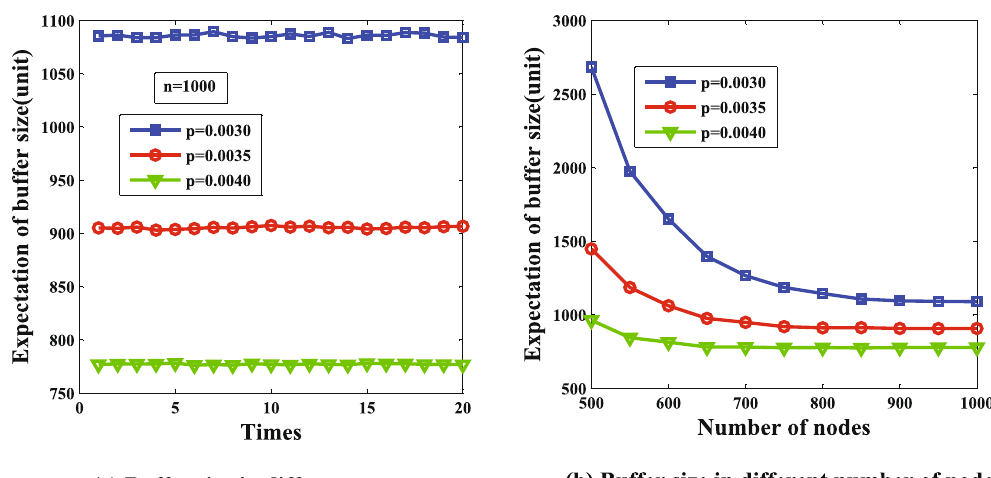
Figure 6. Buffer size in supercritical